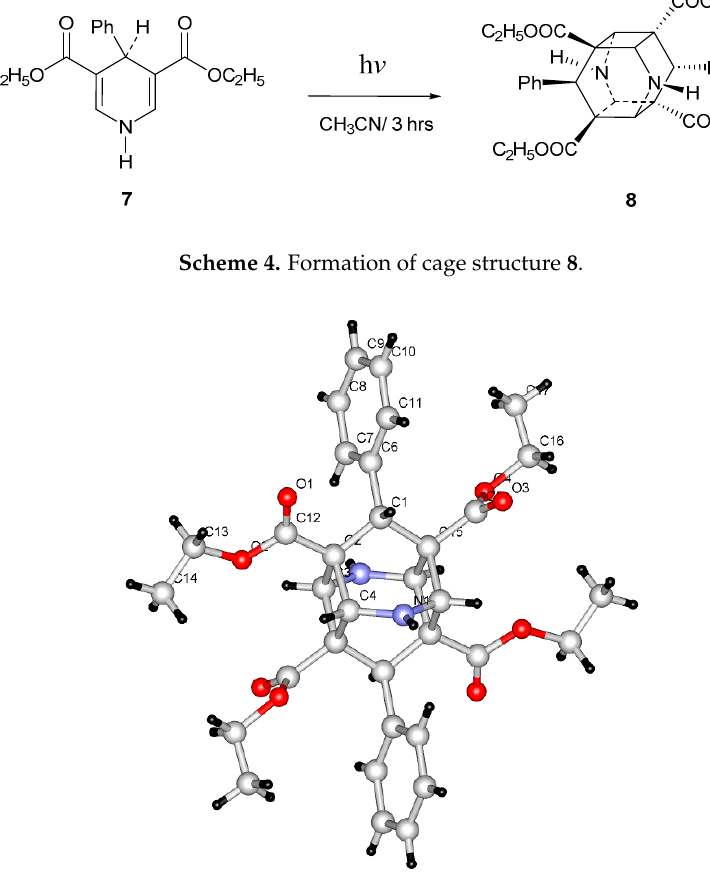
Figure 2. X-ray crystal structure of cage compound 8 .